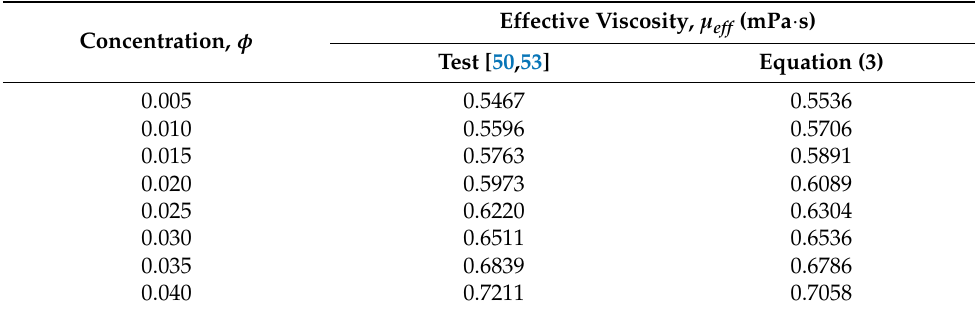
Table 6. Effective viscosity ( µ ef f ) of Al 2 O 3 nanofluid (0.1 v%) at 323 K varying concentration ( φ ).